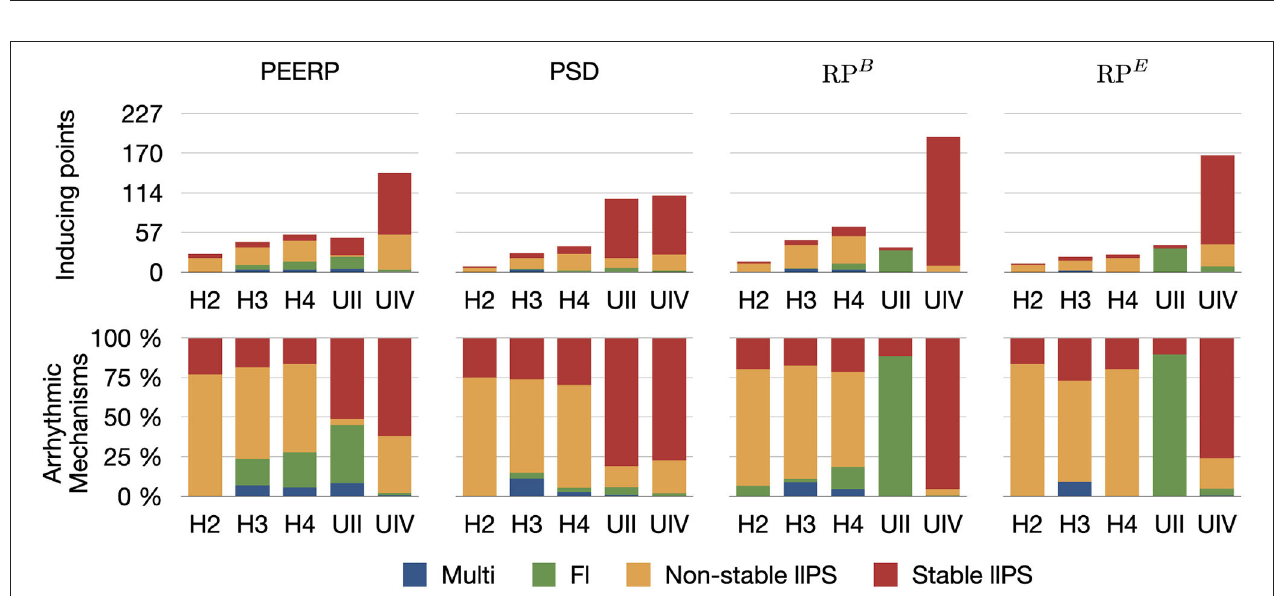
FIGURE 3 | Model UIV partitioned into segments, the black dots represent the fibrotic elements.